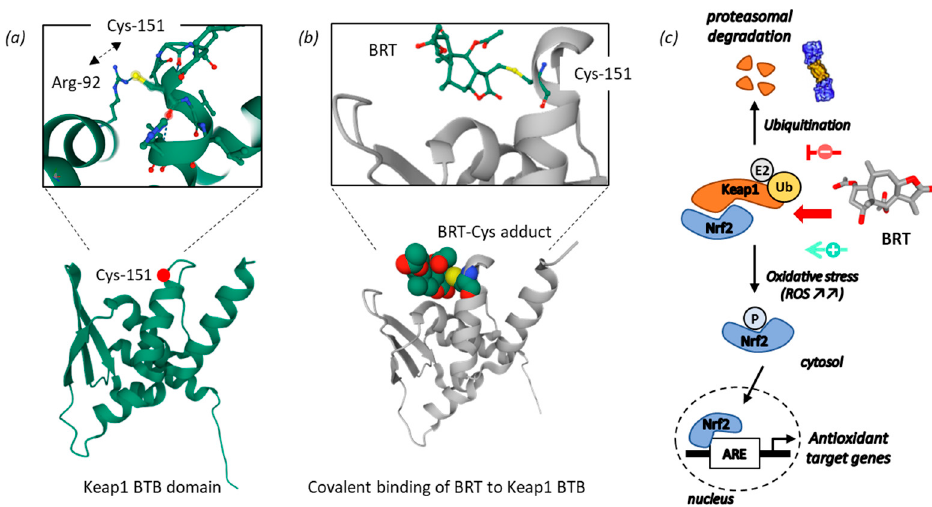
Figure 5. Modulation of the Keap1–Nrf2 pathway by BRT. ( a ) Molecular model of the BTB domain of Keap1 (PDB code: 4CXI) to show the position of residue Cys-151 interacting with Arg-92 to stabilize the protein. ( b ) Model of BRT covalently bound to the Cys-151 residue of Keap 1 (PDB code: 5GIT). ( c ) Nrf2–Keap1 signaling cascade blocked by BRT. Covalent binding of BRT to Cys-151 of Keap 1 leads to activation of Nrf2 (which thus escapes ubiquitination and proteasome-dependent degradation), phosphorylation and nuclear translocation, and then activation of the transcription of antioxidant target genes.